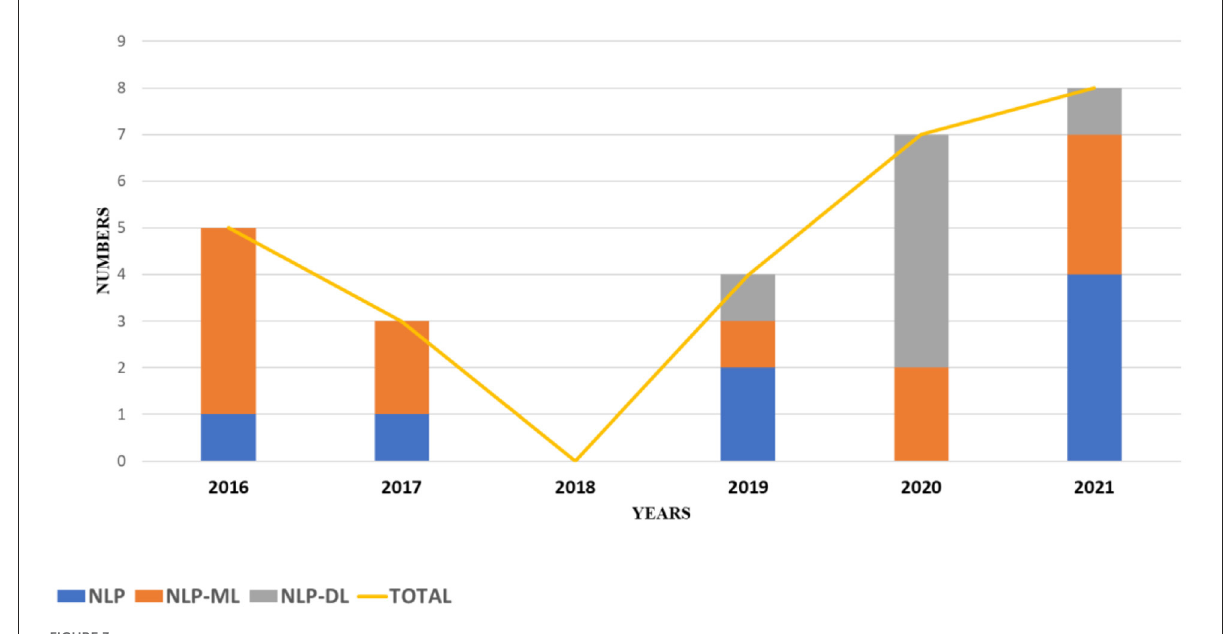
FIGURE3 Distribution by year of